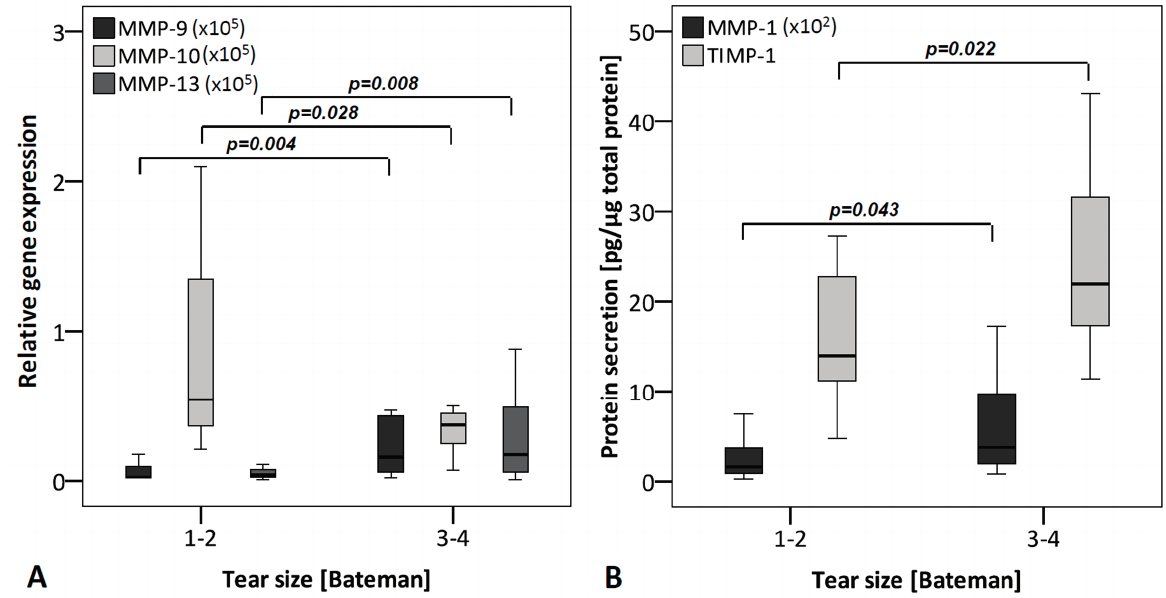
Figure 5. MMPs and TIMPs grouped according to the tear size (small tear size: Bateman score 1–2 ( n = 12); big tear size: Bateman score 3–4 ( n = 18)). ( A ) qRT-PCR was performed to analyze gene expression. The box plot data represent the relative gene expression with 18S as reference gene using the Δ C t method with efficiency